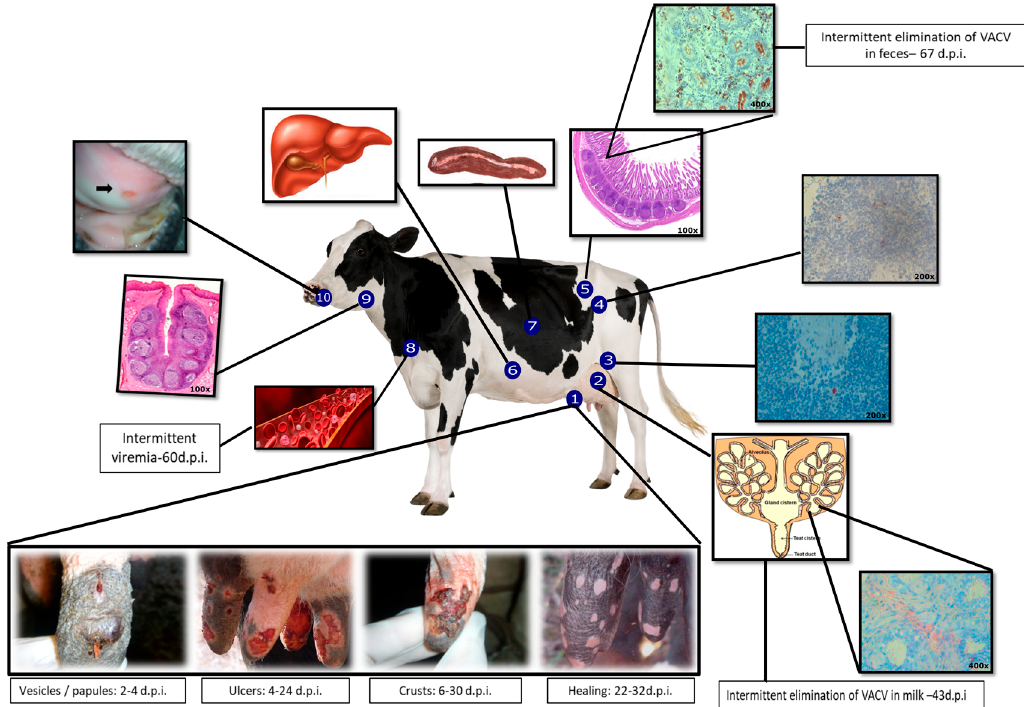
Figure 1. Clinical signs and the proposed model of Vaccinia virus -Guarani P2 (VACV-GP2) pathogenesis in cattle. Multiplication of VACV in the teat epithelium and dissemination by lymphatic and hematogenous routes. 1. Teats; evolution of lesions: primary inoculation site [46,48]; 2. Mammary gland [50,52]; 3. Retromammary lymph node [49]; 4. Mesenteric lymph node [49]; 5. Ileum [49]; 6. Spleen [49]; 7. Liver [49]; 8. Intermittent viremia [47,49]; 9. Tonsil [50]; 10. Ulcer in the oral mucosa [46].